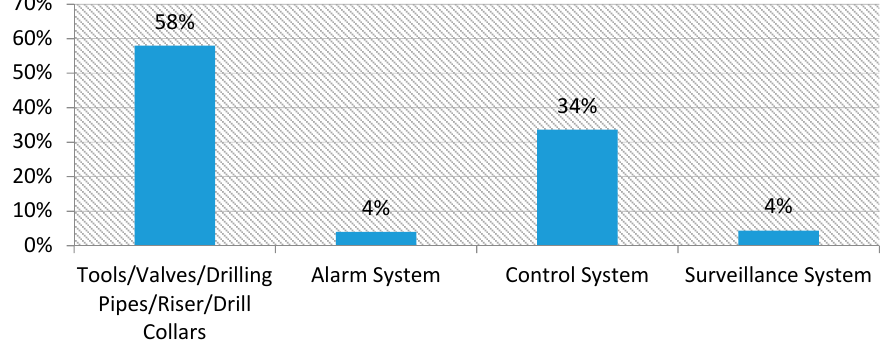
Figure 5. Subtask for User Equipment.